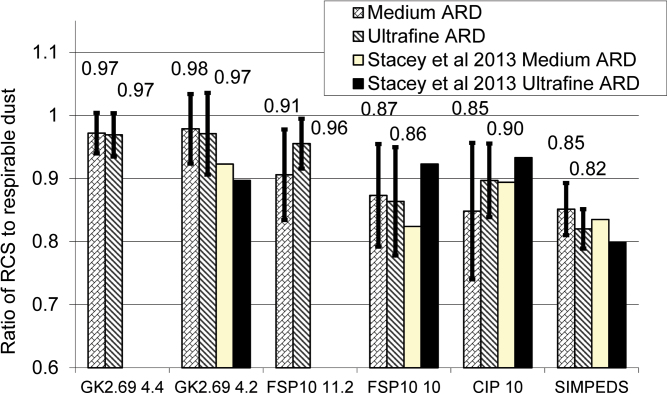
Ratio of RCS to respirable dust.